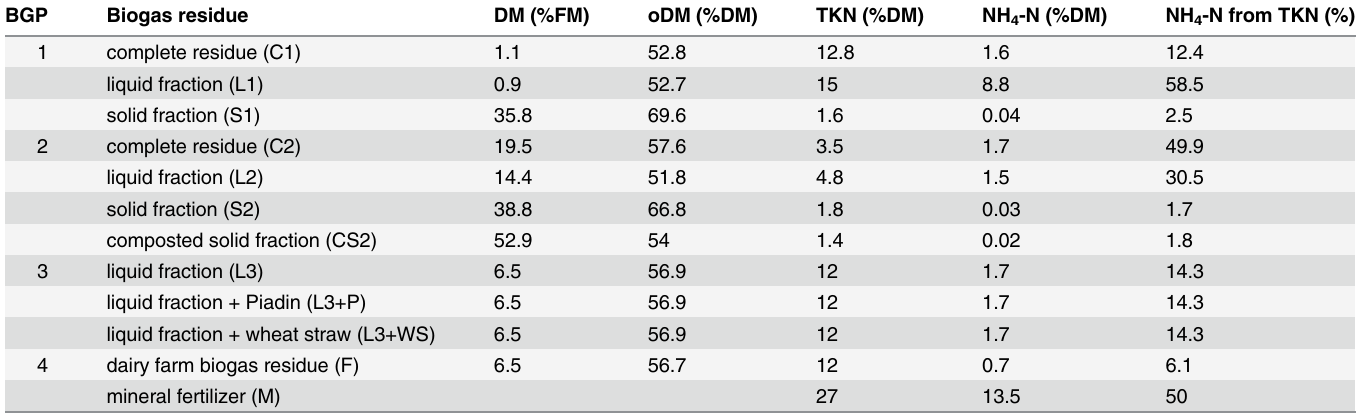
Table 1. Chemical properties of used BGRs and mineral fertilizer. TKN = total Kjeldahl nitrogen; NH 4 -N = ammonia nitrogen, FM = fresh matter, DM = dry matter, oDM = organic dry matter, BGP = biogas plant. BGP Biogas